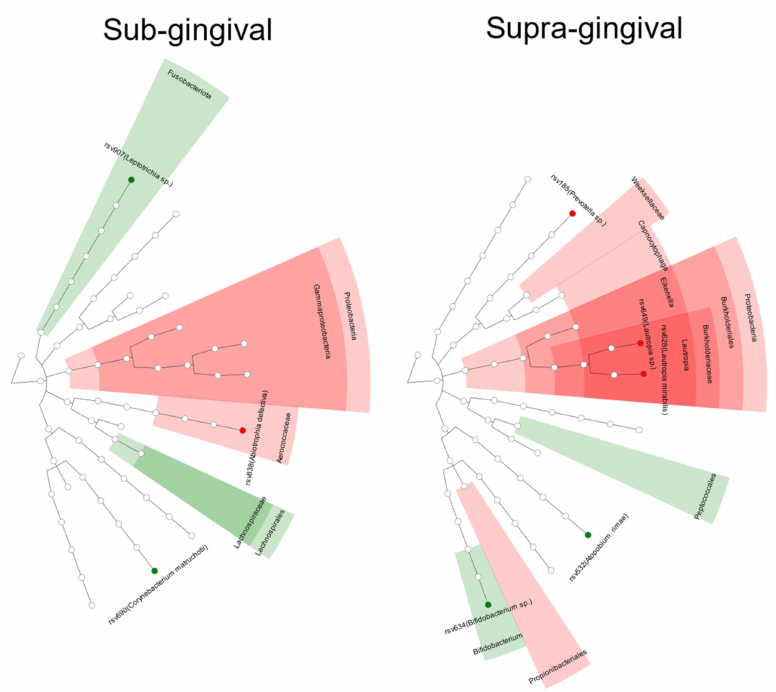
Figure 5. Differences in abundance of certain taxa between the groups (red = PTB, green =